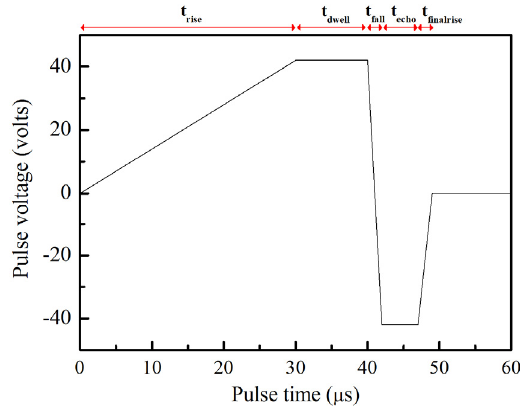
Figure 1. Bipolar waveform applied to glycerol solution (80 vol% glycerol) (t rise : 30 μ s, t dwell : 10 μ s, t fall : 2 μ s, t echo : 5 μ s, t finalrise : 2 μ s, at ±42